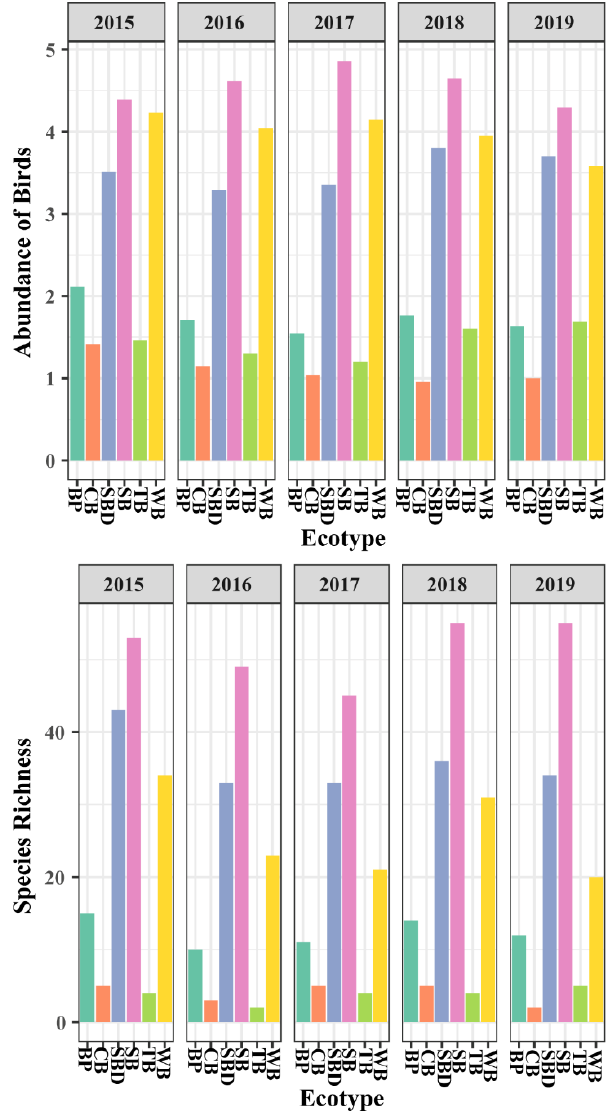
Figure 2. Annual abundance of birds and species richness sorted by ecotypes. Data for abundance of birds were presented in logarithmic form. TB: terrestrial birds; BP: birds of prey; CB: climbing birds; SBD: songbirds; WB: wading birds; SB: swimming birds. Table 1. Effects of years, semi-years and ecotypes on species richness and abundance of birds. Variable Years Semi-Years Ecotypes F p F p F p Species Richness 5.148 0.00153 ** 0.512 0.47774 169.234 <0.01 *** Abundance of Birds 1.187 0.328 1.92 0.172 18.776 <0.01